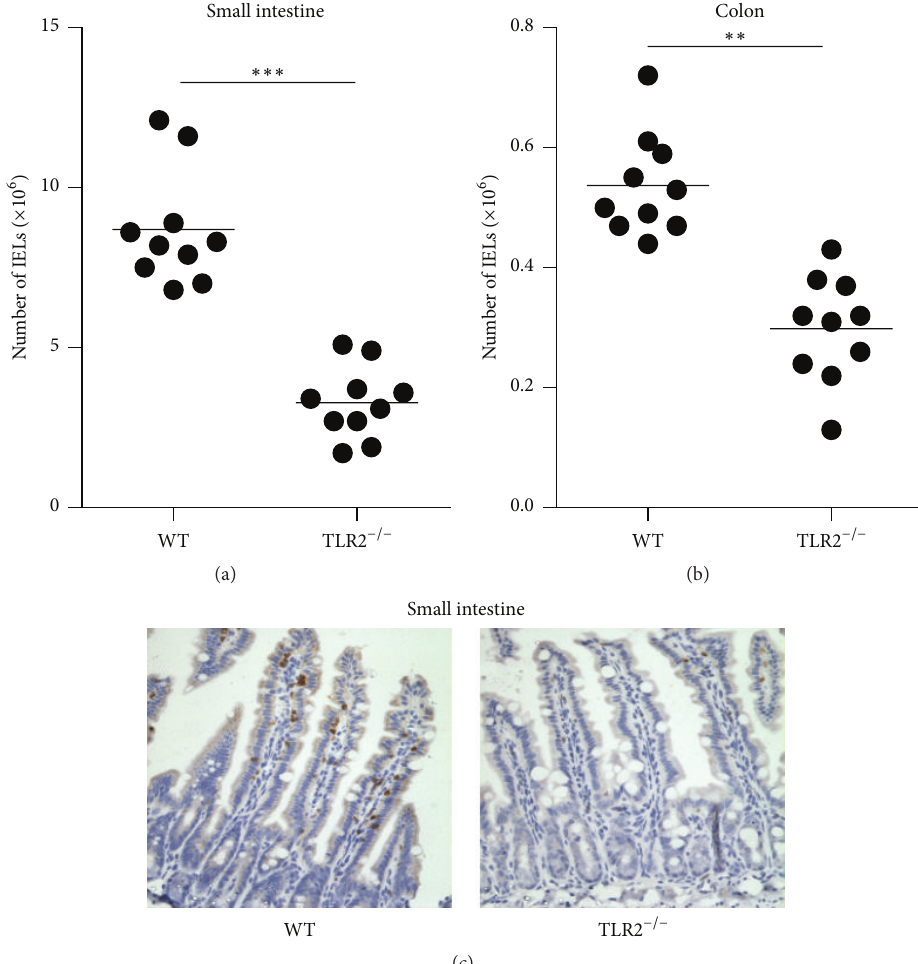
Figure 1: Changes in the number of intraepithelial lymphocytes (IELs) in TLR2 −/− mice. (a and b) The numbers of IELs in the small intestine (a)andcolon(b)ofTLR2 −/− miceandindividualcontrolmice.Horizontalbarsindicatethemean.Tenmicepergroupfromthreeindependent experiments. (c) The IEL was detected through immunohistochemistry with CD3. Images are 400x. ∗∗ 𝑃 < 0.01 ; ∗∗∗ 𝑃 < 0.001